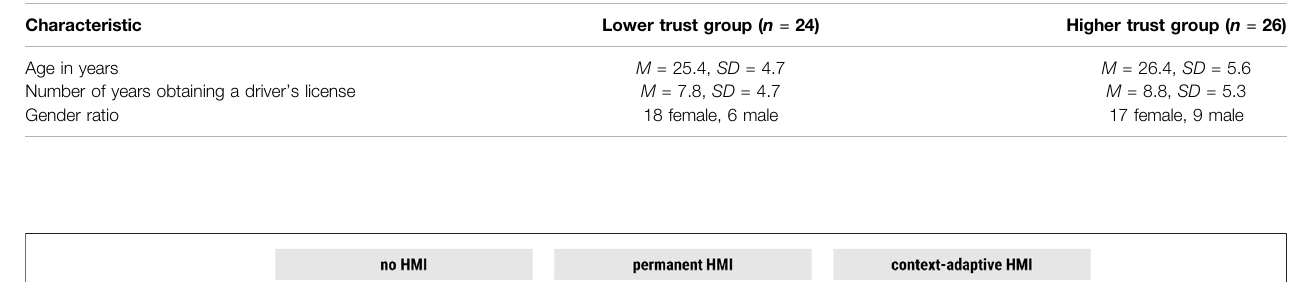
Frontiers in Human Dynamics |